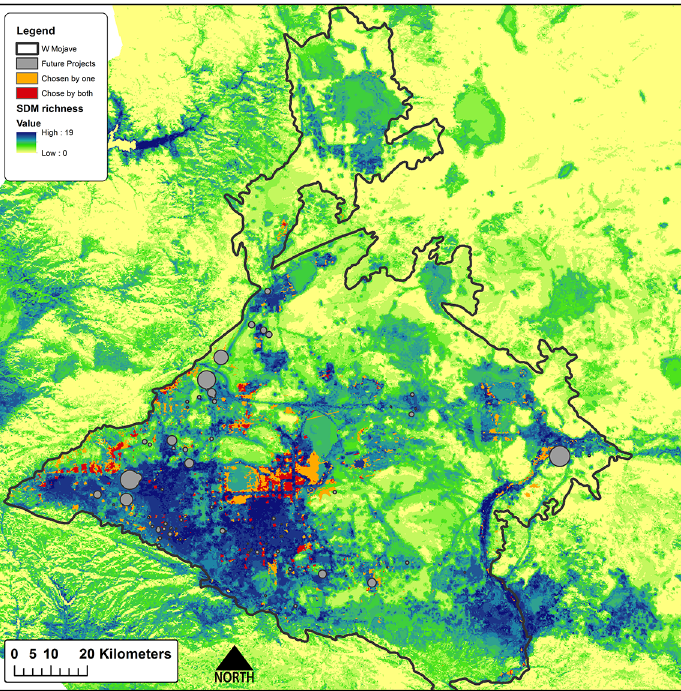
Fig 6. Scenario agreement. The agreement of both scenarios (red), areas chosen by one scenario (orange), over modeled species richness.